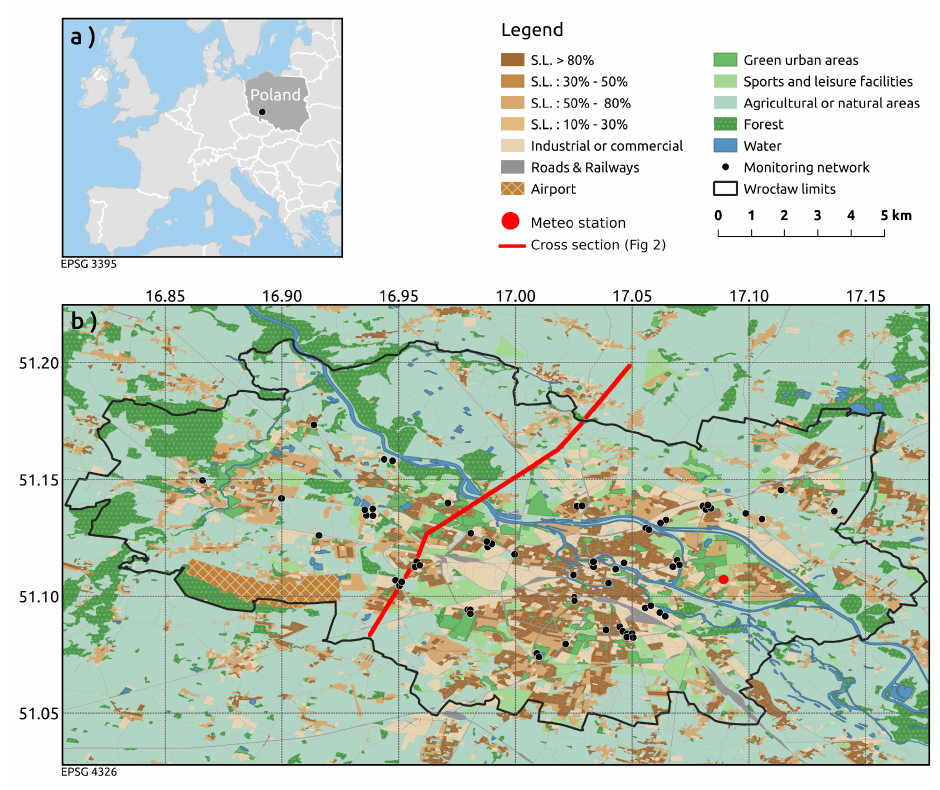
Figure 1. Location of the study area ( a ), including the Wrocław land cover structure and monitoring wells ( b ). Soil sealing layer (S.L.) thresholds defined by the Mapping Guide for a European Urban Atlas, Ref. Ares